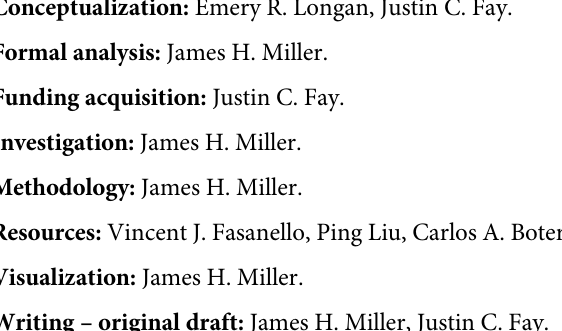
S10 Fig. Comparison of fitness differences and colony size ratios. The log of colony size ratios from Fig 3 were calculated by dividing the colony size of each evolved replicate by the average size of its respective ancestors on copper (A) and sodium (B) plates. The location of the inset is indicated by the black